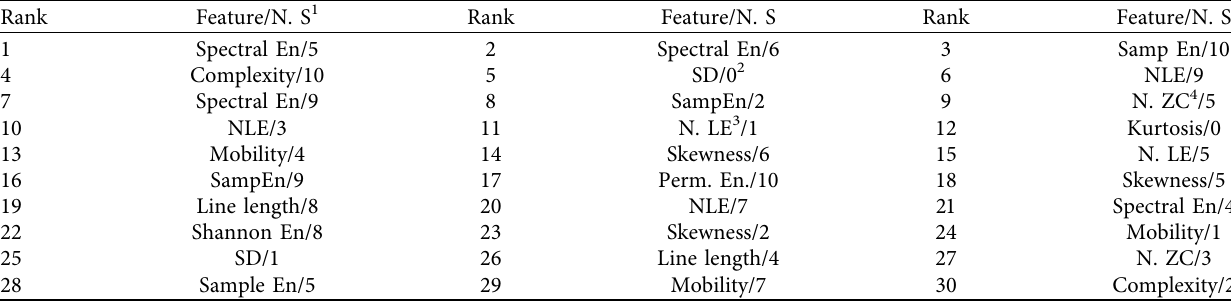
Figure 6: F -value for all 165 features by using analysis of variance. Table 4: 30 high-ranked features selected by